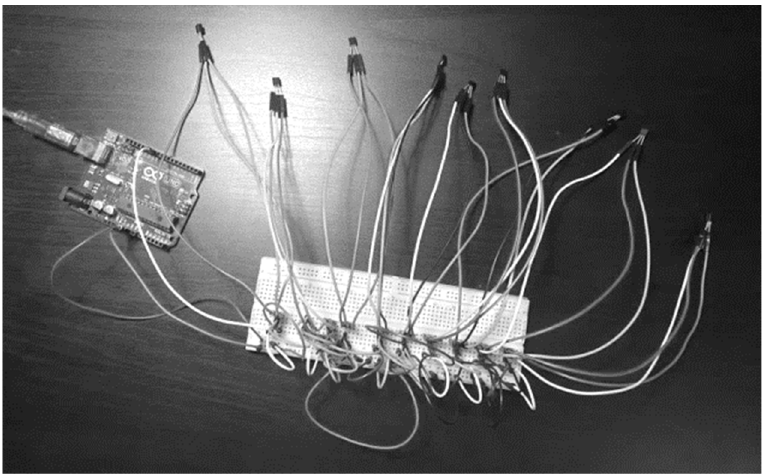
Figure 2. Device with DS18B20 sensors.